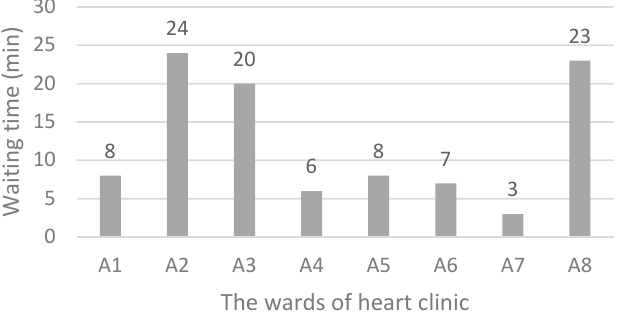
Figure 9. Waiting times after the second scenario implementation.